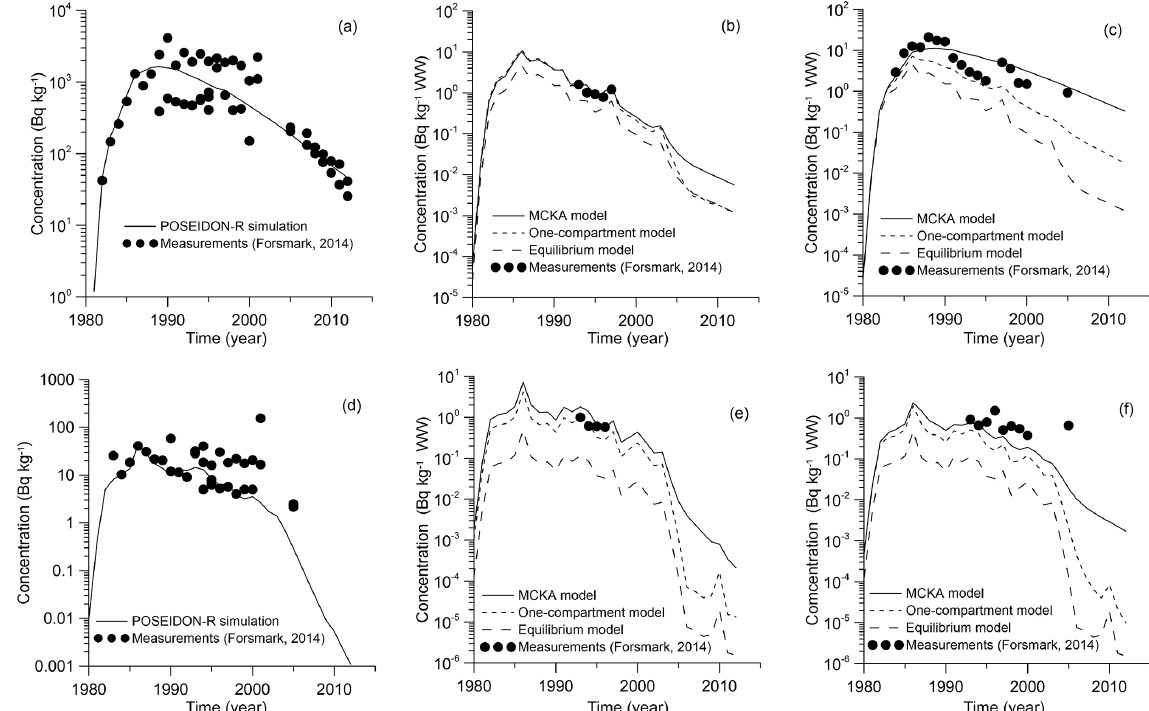
Figure 8. Comparison between calculated and measured 60 Co (Forsmark, 2014) concentrations in bottom sediment (a) , non-piscivorous fish (herring) (b) and coastal predator fish (pike) (c) and 54 Mn concentrations in bottom sediment (d) , non-piscivorous fish (herring) (e) and coastal predator fish (pike) (f) for the coastal